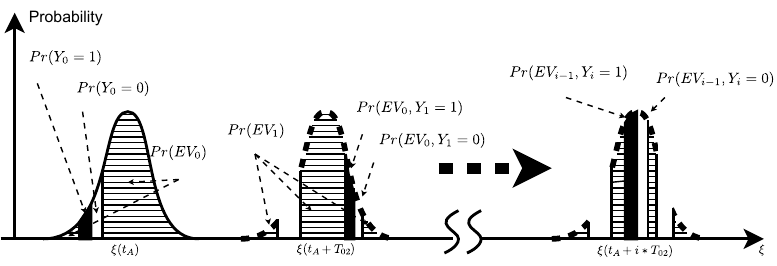
Figure 6: The intuitive interpretation of the repetitive